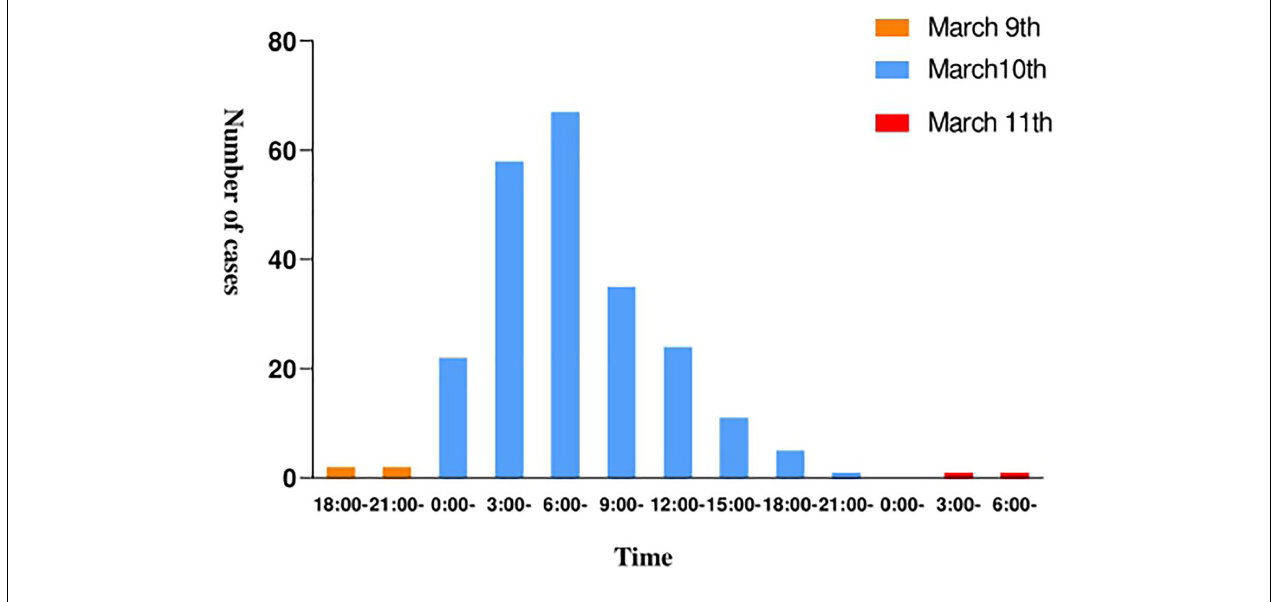
FIGURE 1 | Morbidity curve of a food poisoning incident at a canteen in Beijing.